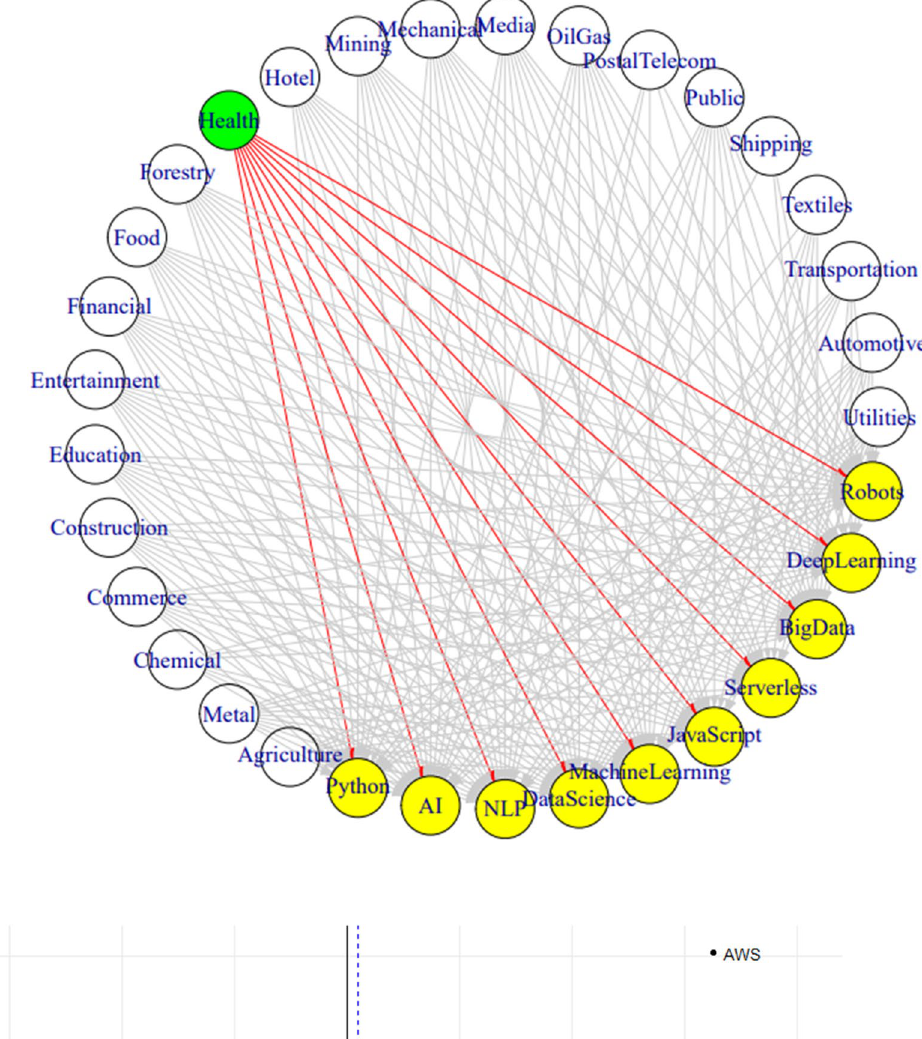
Fig. 8 This network graph utilizes red arrows that depict relationships between tweets towards the healthcare indus- try, highlighted in green near the top of the image, and all of the trending terms which are lighted in